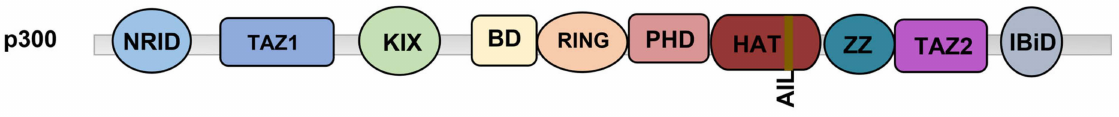
Figure 1. Schematic of the basic structure of p300, which contains the N-terminal nuclear receptor interaction domain (NRID), transcriptional junction zinc finger 1 (TAZ1), kinase-induced CREB interaction domains (KIX), bromine domain (BD), RING domain, plant homology domain (PHD), HAT domain, Z-type zinc finger domain (ZZ), TAZ2 domain and IBiD